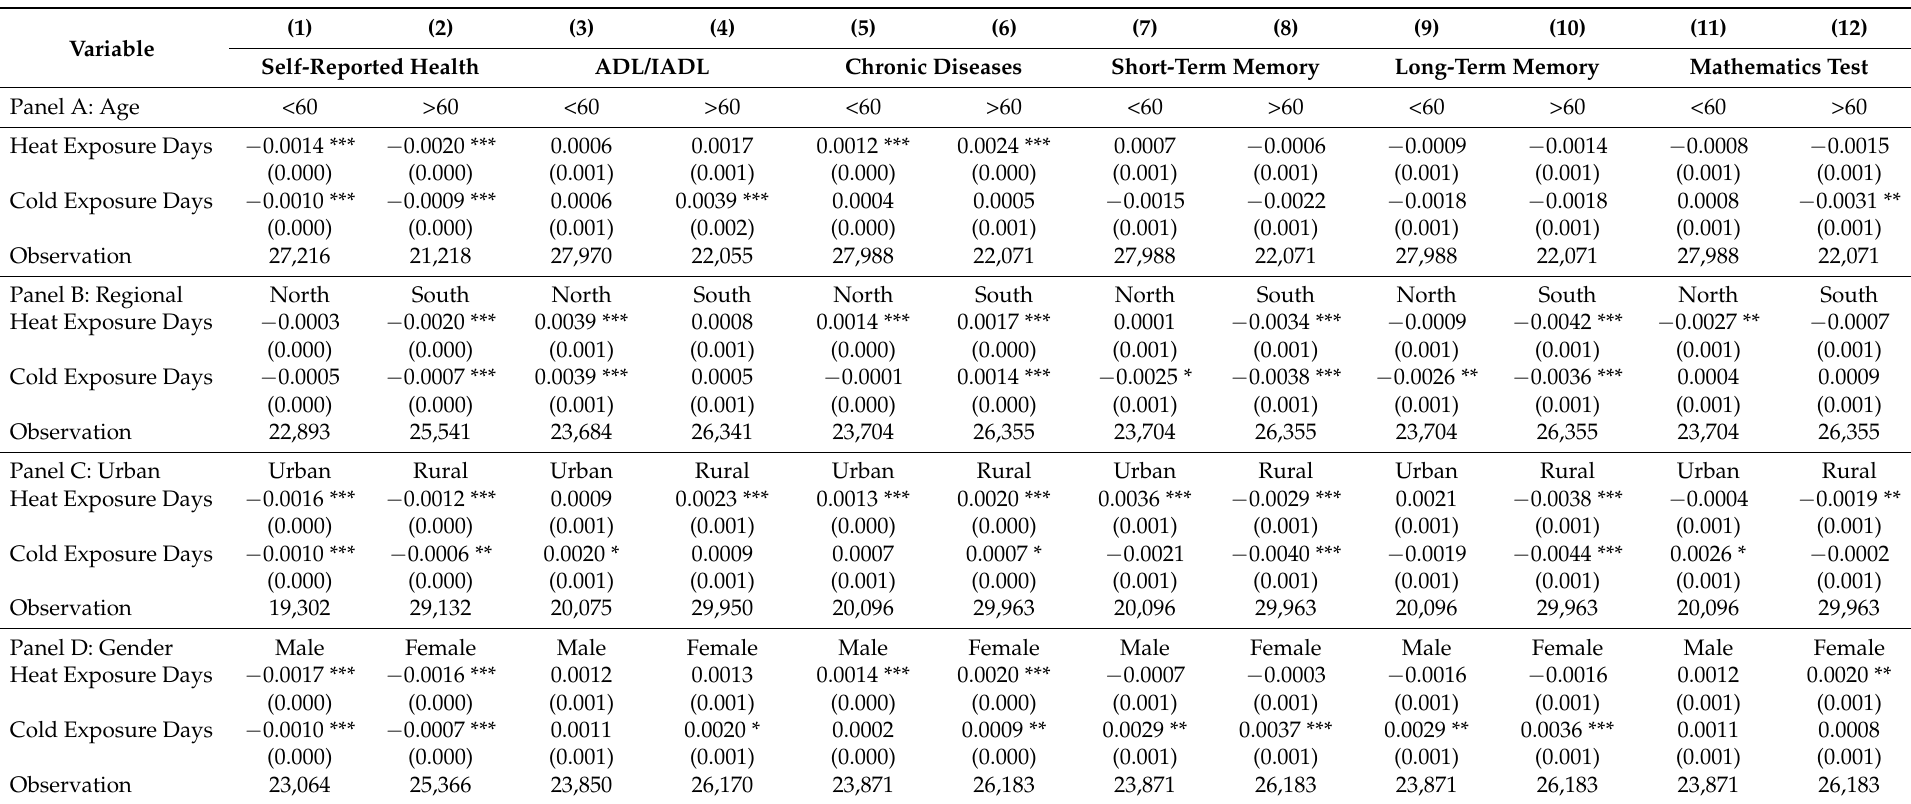
Table 4. Regression results of the